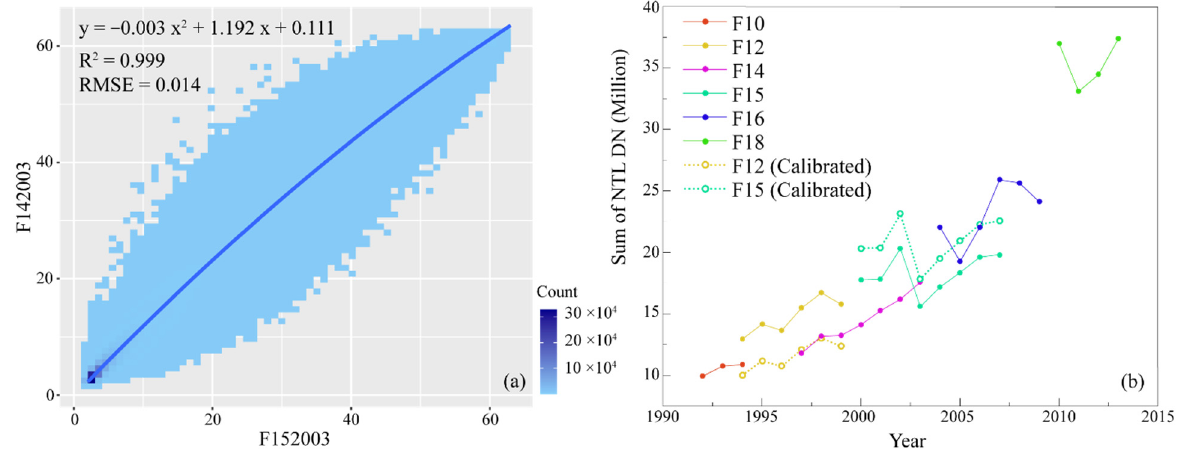
Figure 4. ( a ) The fitting parameters of the F14-based F15 mutual calibration model and ( b ) the variation trend of the total DN value of calibrated lit pixels.